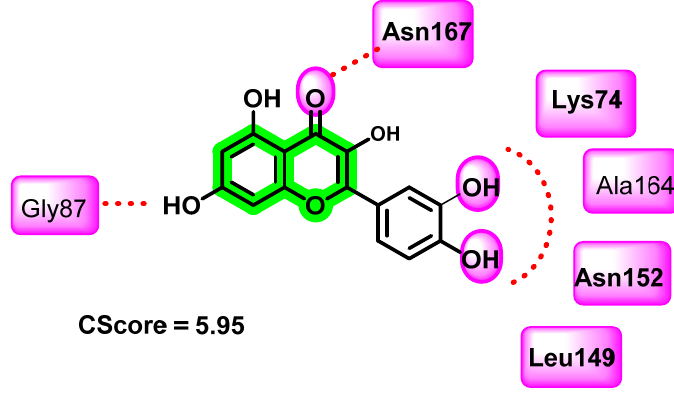
Figure 6. Hydrogen bonding interactions of quercetin with DENV NS2B-NS3 protease.